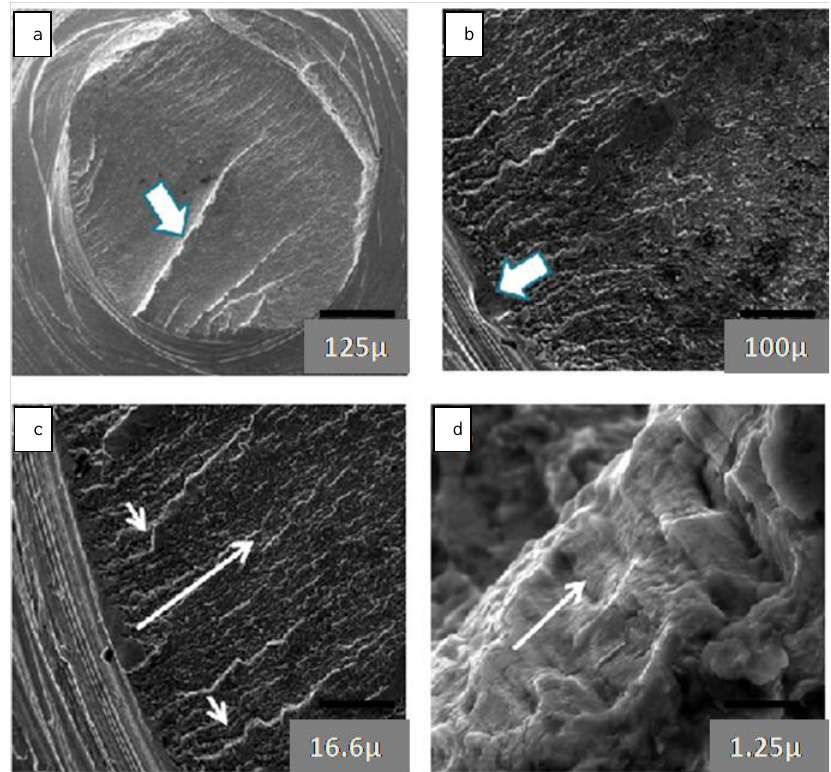
Fig. 4. Scanning electron fractographs of the retrieved implant